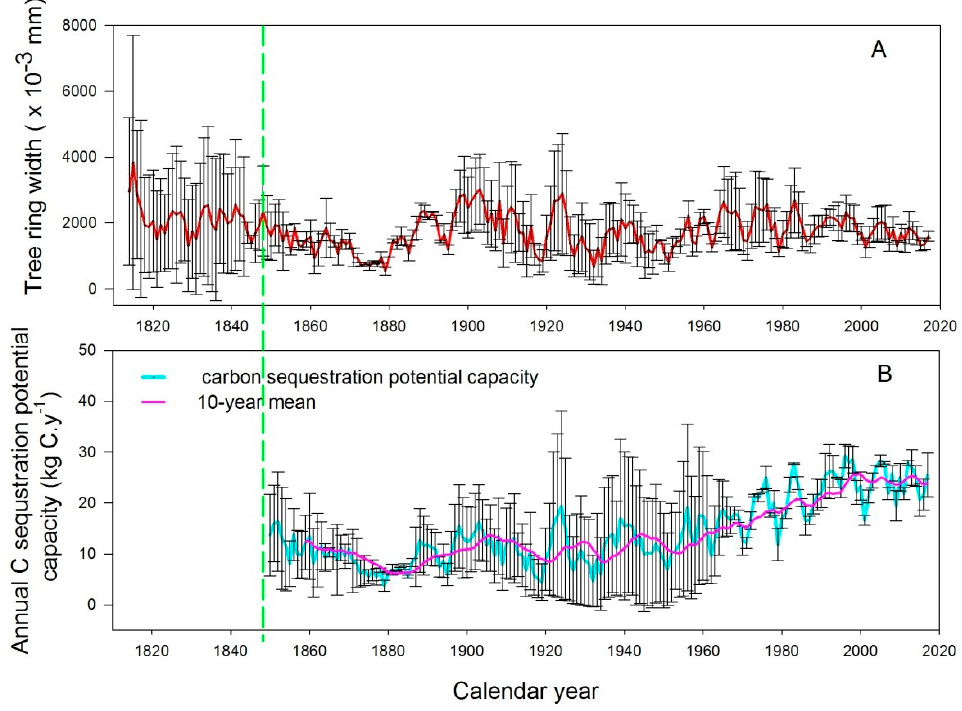
Figure 2. Tree-ring width chronology ( A ), and carbon sequestration potential capacity ( B ) in aboveground biomass of P. schrenkiana in the Tianshan Mountains. (C sequestration potential capacity: carbon sequestration potential capacity).